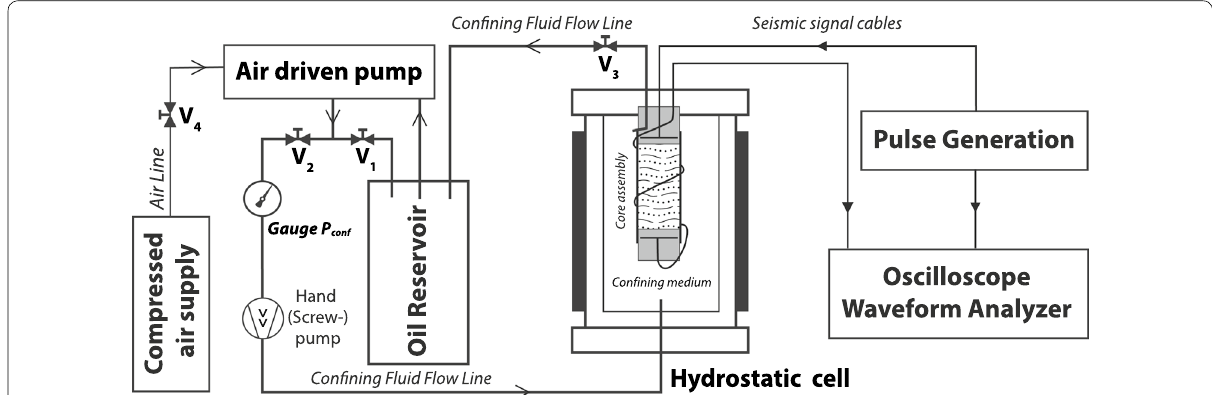
Fig. 4 Schematic setup of the seismic apparatus used to measure ultrasonic velocities up to 260 MPa confining pressure and at room temperature. The core assembly is accommodated inside a hydrostatic vessel, where the oil is the confining